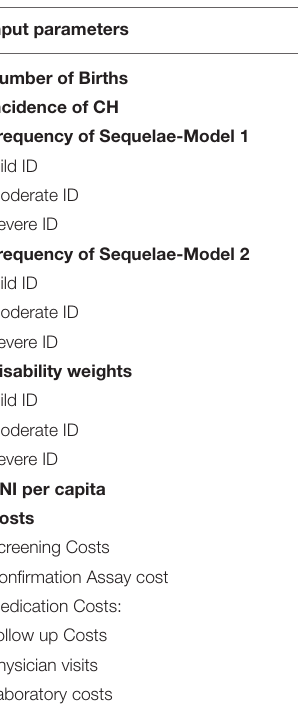
TABLE 1 | Input parameter pooled estimate for incidence of hypothyroidism in